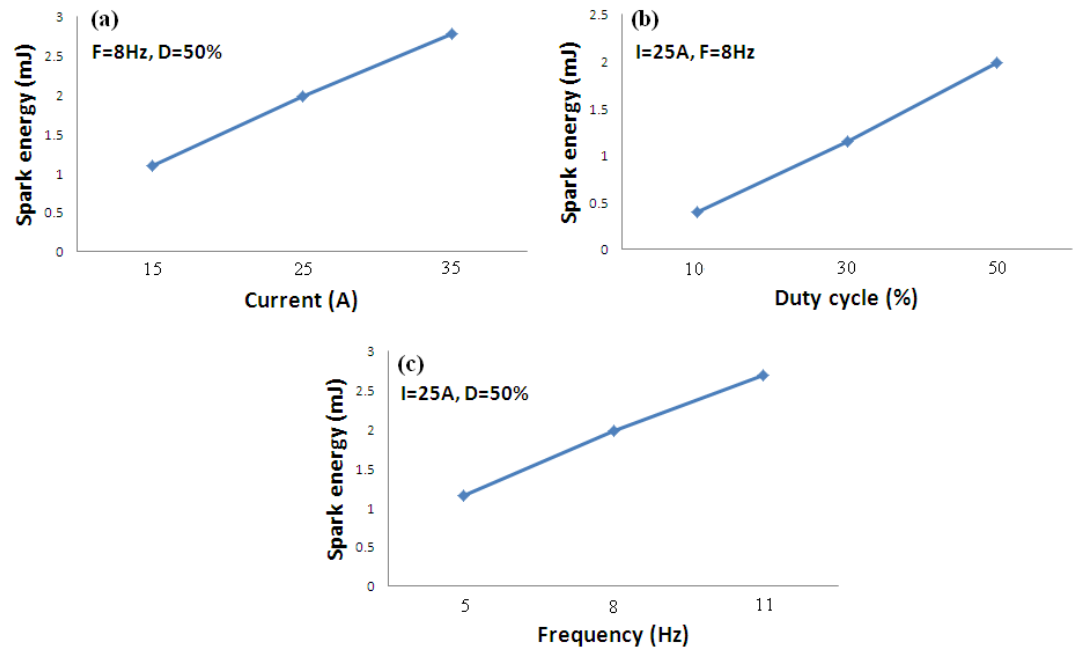
Figure 3. Variation of Spark energy with ( a ) current limits, ( b ) duty cycles and ( c ) frequencies.